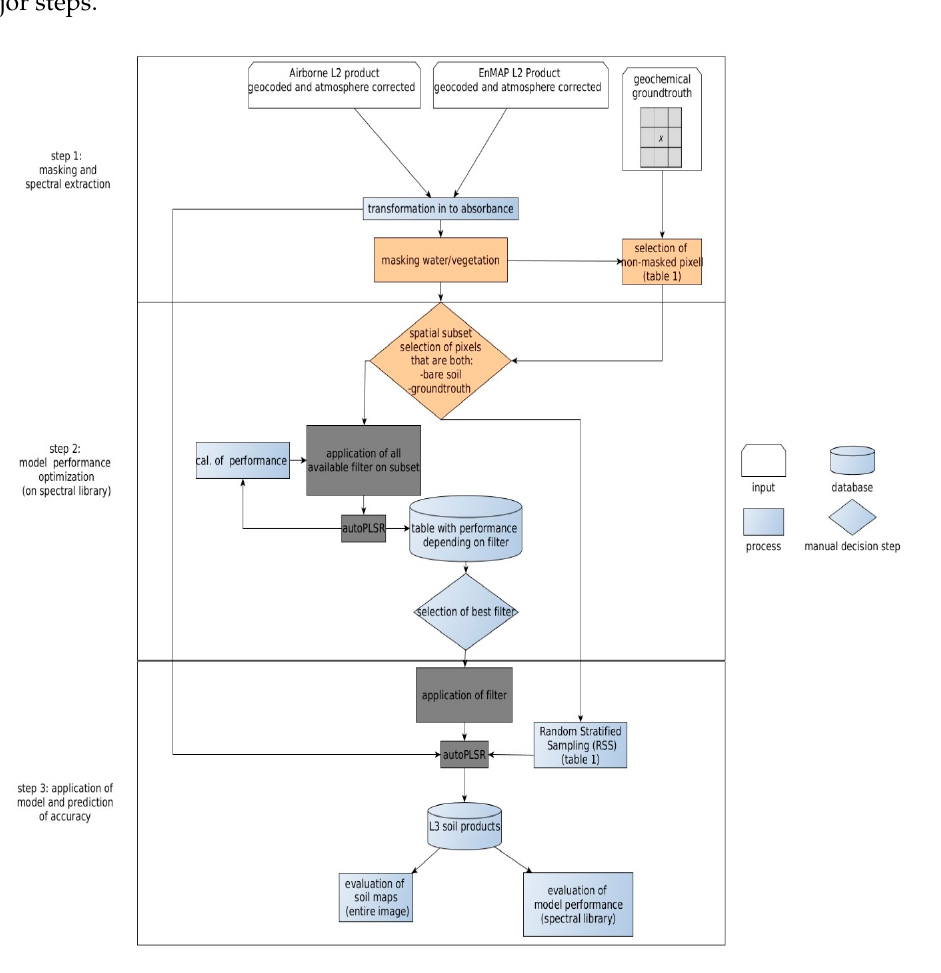
Figure 4. Work flow of soil prediction modeling in this study. Grey shaded boxes indicate use of the EnMAP toolbox and light color boxes the use of the Hysoma toolbox, while blue boxes indicate steps developed uniquely in this study.